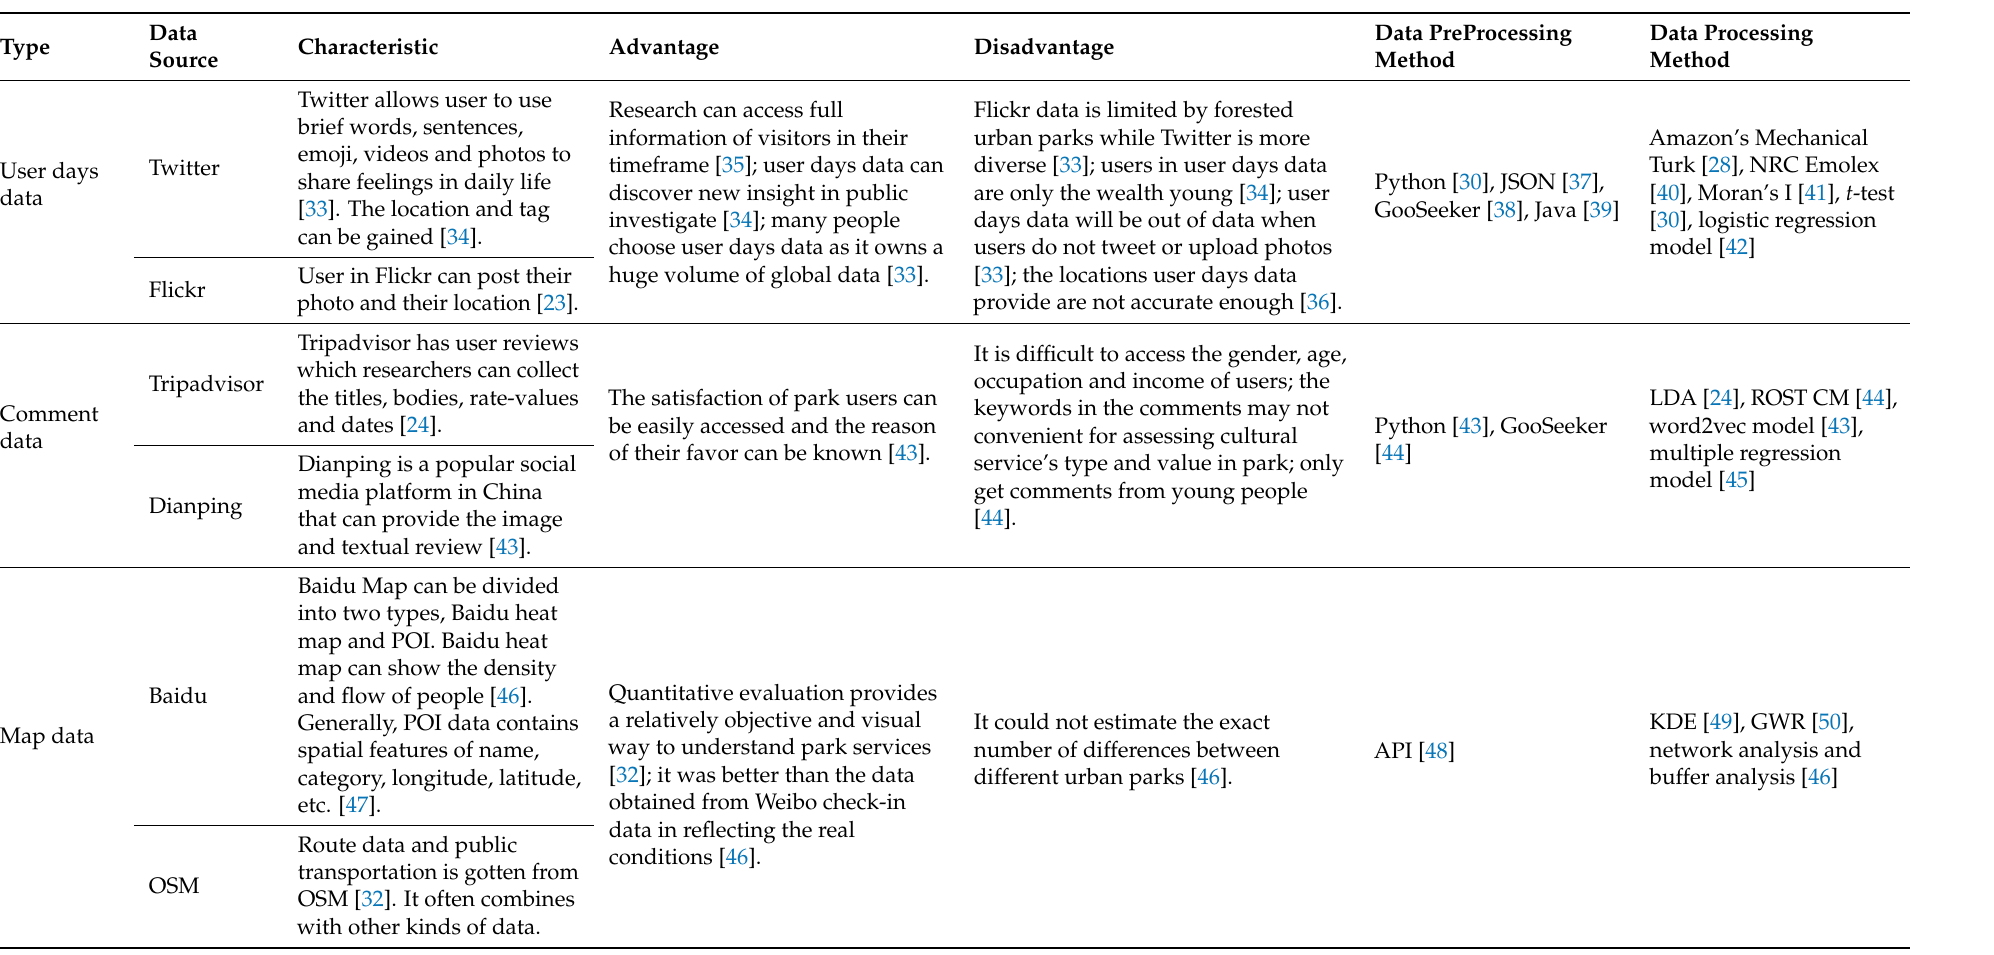
Table 1. The major characteristics (pros and cons) and analytical methods of big data in urban